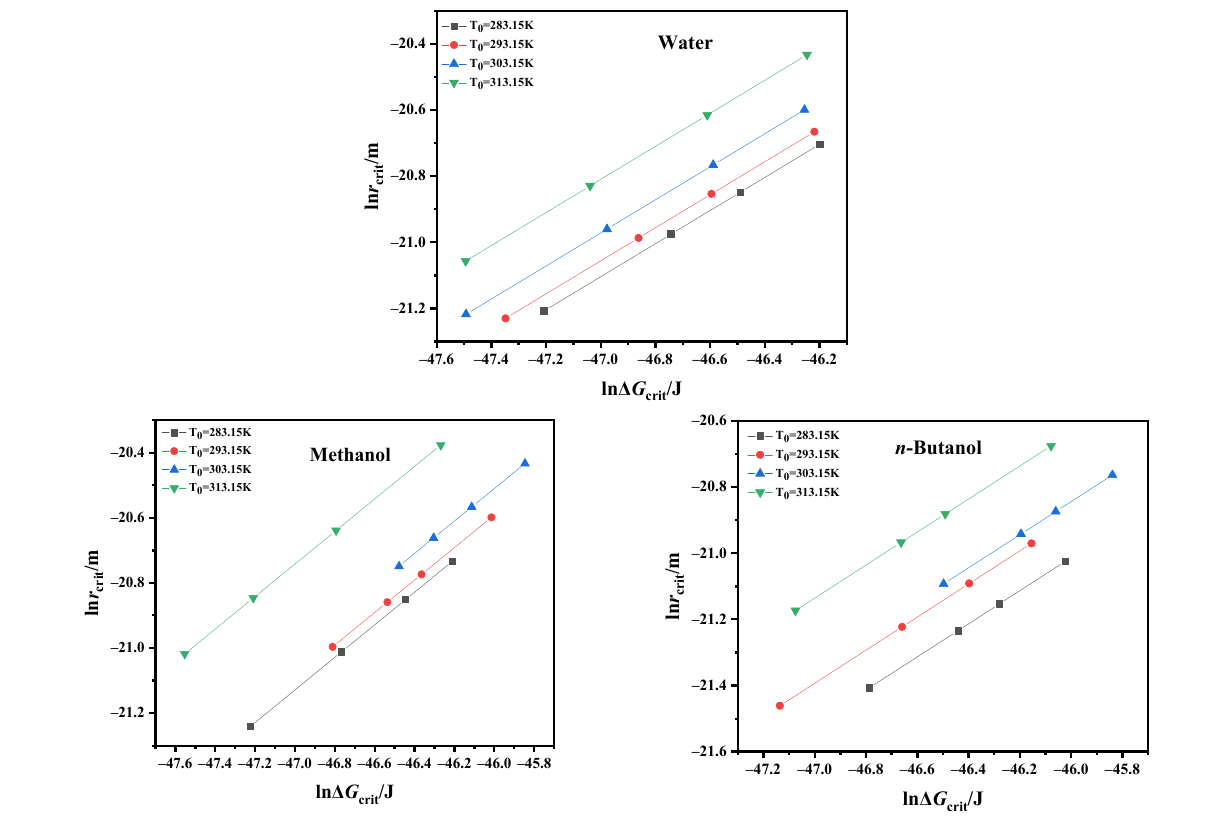
Figure 12. Relationship between ln ∆ G crit and ln r crit . Because of Formulas (10) and (12), the relationship between nucleation rate and ∆ µ can be calculated. If the pre-exponential factor and solid–liquid interface tension were constants, and were not affected by temperature, cooling rate and solvent, ln J should be linearly related to γ 3 / T 1 ∗ ∆ µ 2 . As shown in Figure 13, the value change in nucleation rate with driving force does not follow a linear correlation. In addition, in Figure 14, at a given saturation temperature, J and ∆ µ are in a straight line relationship. Perhaps this formula does not apply to this system; the reason for this needs to be further studied. When the saturation temperature increases, it is beneficial to increase the rate of nucleation, and it is more beneficial to the nucleation process of adipic acid. When the saturation temperature remains constant, the nucleation rate increases, with successive increases in the cooling rate. We found that the crystallization driving force increased as the saturation temperature decreased. In practice, we find that the nucleation rate does not always increase with the increasing driving force of crystallization, but also depends on the saturation